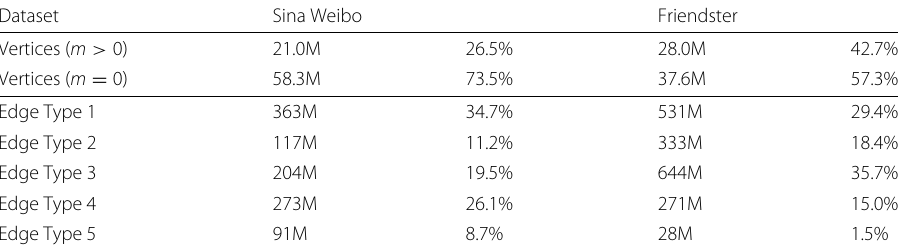
Table 3 Classification of edges and vertices in social networks. M represents a million. The types of edges are defined as in Fig.